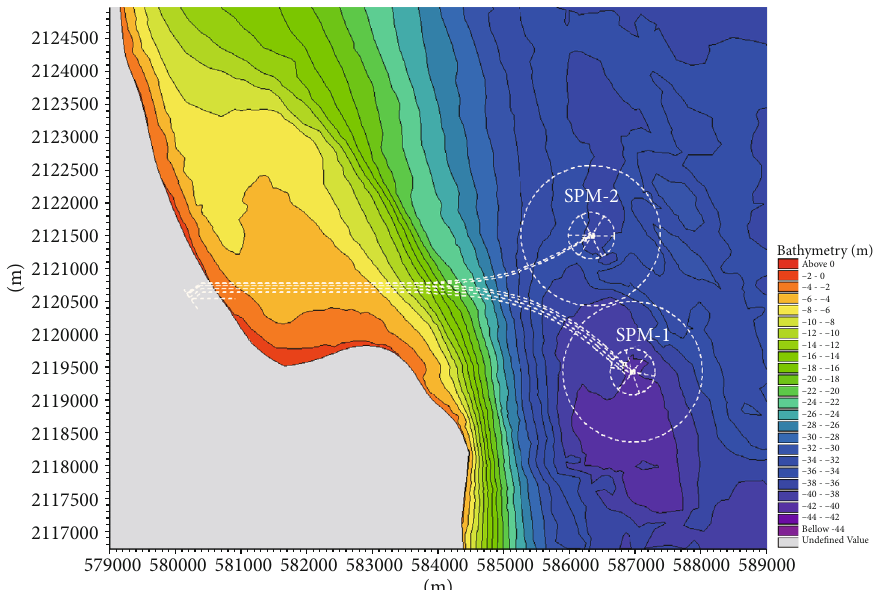
Figure 6: Nearshore bathymetry of Ras Markaz crenulated